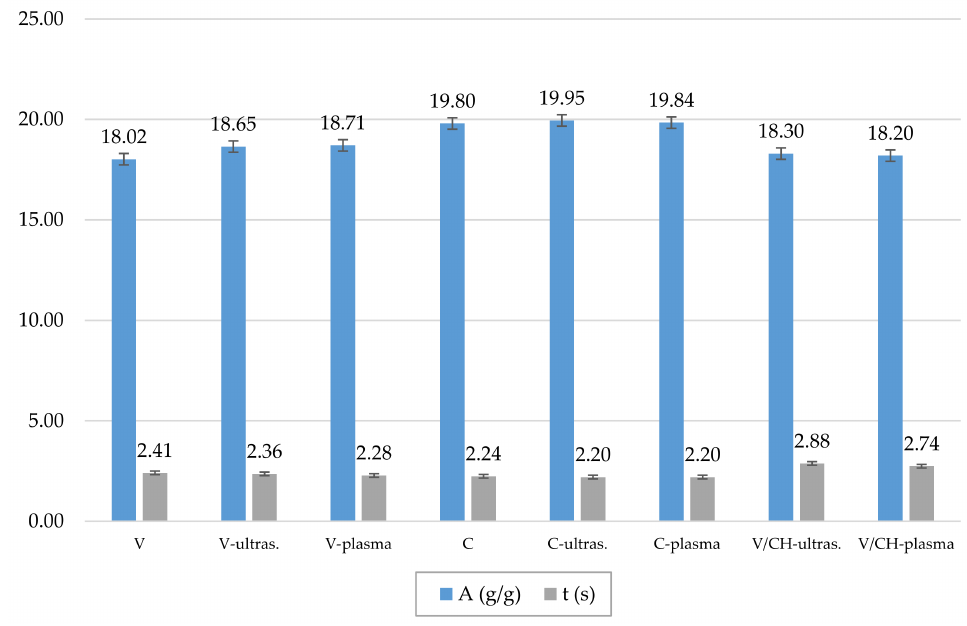
Figure 2. Absorptive capacity ( A ) and liquid absorbency time ( t ), for all tested fibers, with the standard deviation.